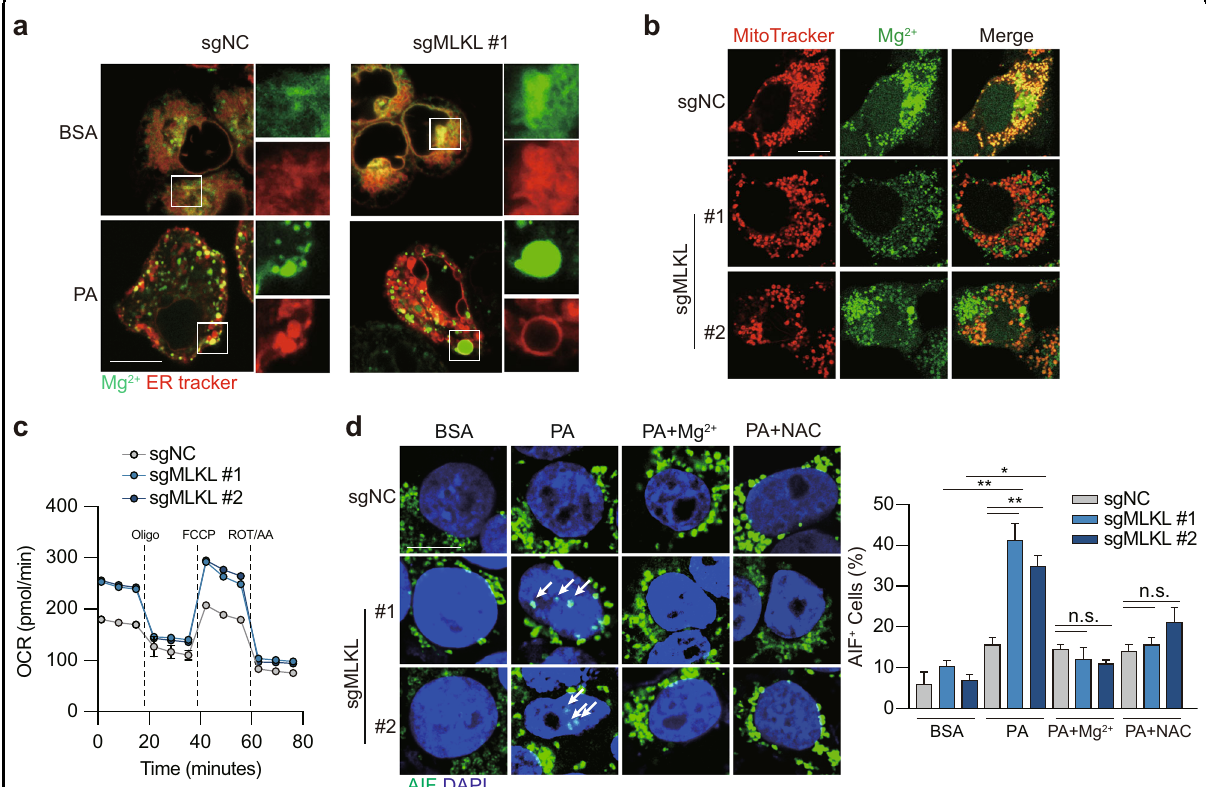
Fig. 5 MLKL de fi ciency disrupts Mg 2 + homeostasis in the ER. a Mg 2 + signaling in ER. MLKL-KO Hepa 1 – 6 and control cells were treated with BSA or 0.2 mM PA for 12 h. ER Mg 2 + signal was visualized by co-staining the cells using ER Tracker and Mag-Fluo4-AM. Shown were representative fl uorescent images, scale bar, 10 μ m. b Mg 2 + signal in mitochondria. Cells were treated as in a . Mitochondrial Mg 2 + signal was visualized by co- staining the cells using MitoTracker and Mag-Green-AM. Shown were representative fl uorescent images, scale bar, 10 μ m. c Oxygen consumption rate (OCR) measurement. Cells were treated as in a . Oligomycin (Oligo, 2 μ M), FCCP (1 μ M) and rotenone/antimycin (ROT/AA, 0.5 μ M) were added as indicated. d AIF staining. MLKL-KO Hepa 1 – 6 and control cells were pretreated with Mg 2 + (MgCl 2 , 10 mM) or N -acetyl-L-cysteine (NAC, 2 mM) for 1 h followed by treatment with BSA or 0.2 mM PA for 12 h. Left, representative images, scale bar, 10 μ m. Arrows indicate AIF staining in the nucleus. Right, quanti fi cation of nuclear AIF positive cells. Data are represented as means ± SEM. Two-tailed Student ’ s t -test was used for statistical analysis. ns, not signi fi cant; * P < 0.05, ** P < 0.01, *** P <